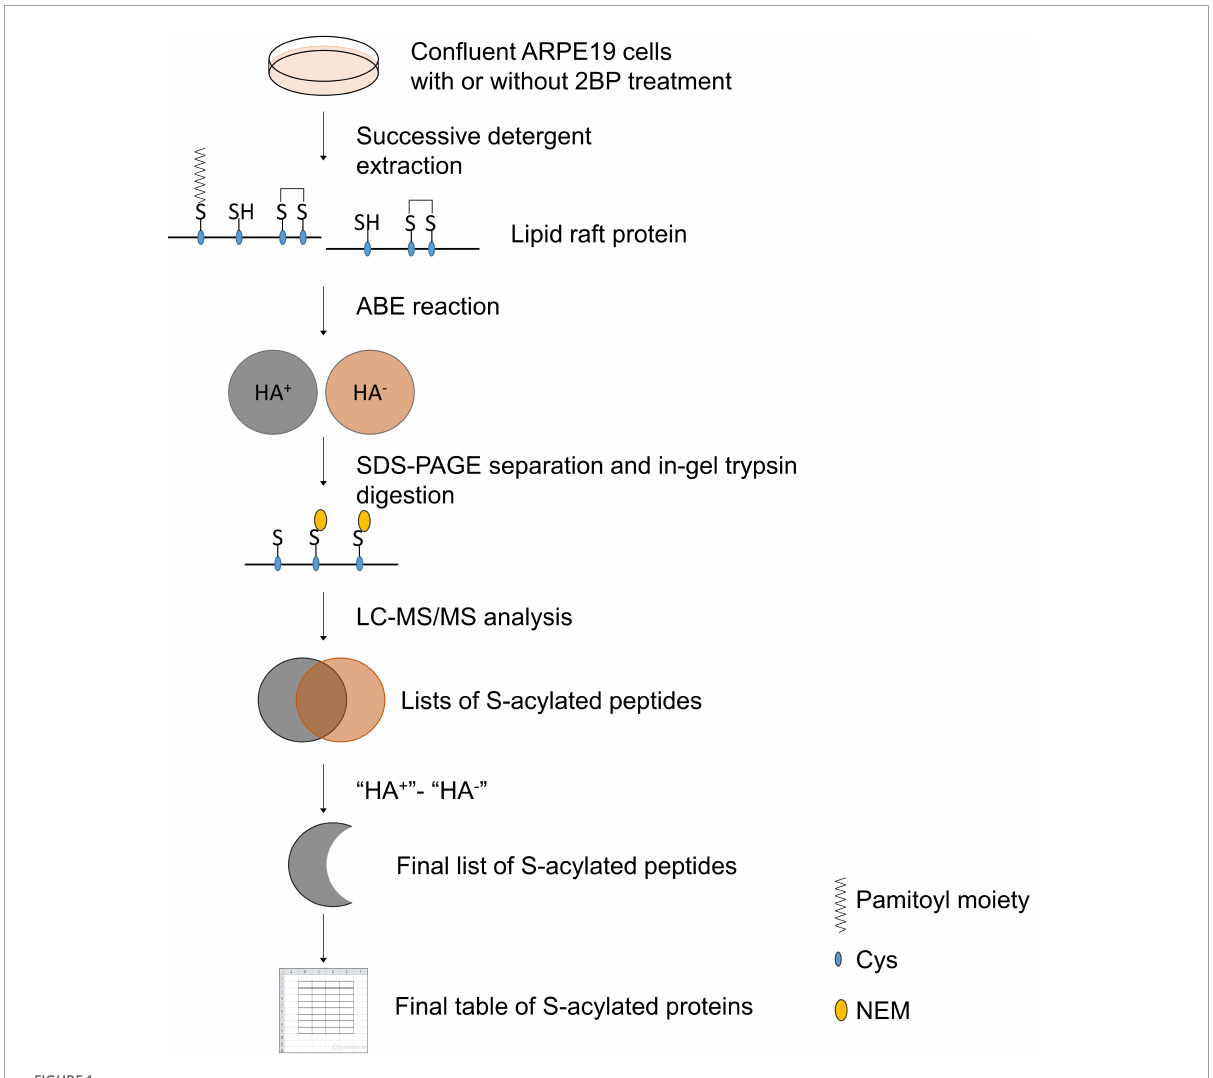
FIGURE1 Schematic presentation of experimental design and data